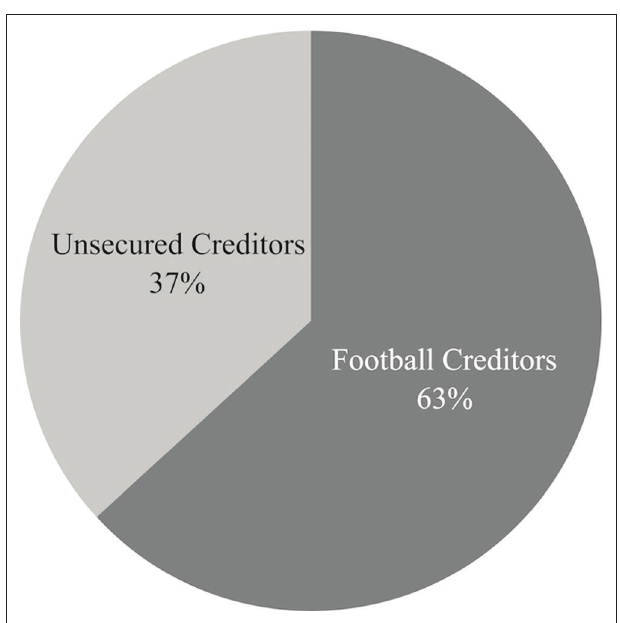
Figure 3: Portsmouth (2010) Payment